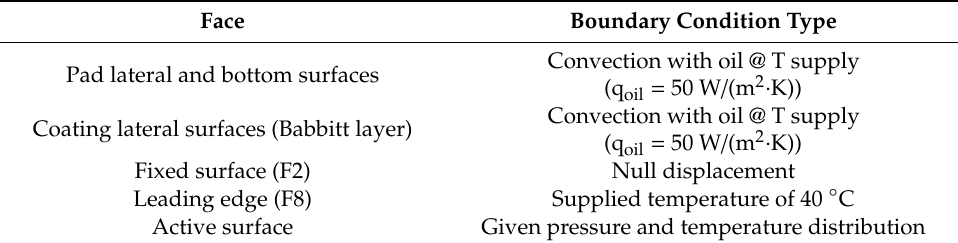
Figure 3. Boundary conditions of a single pad. Table 3. Boundary conditions used in the model of the pad.